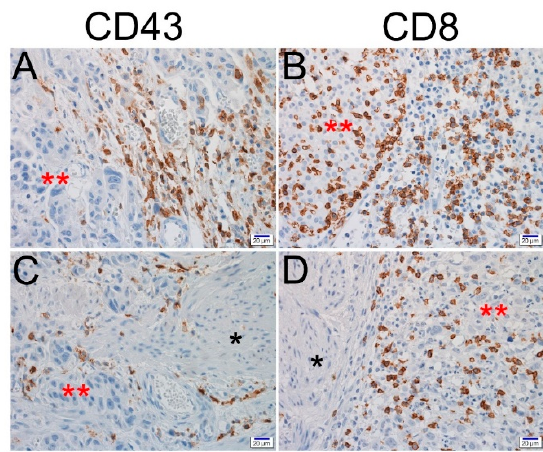
Figure 2. Representative images of CD43 and CD8 immunohistochemical staining in urothelial carcinoma of the bladder (UCB). Positive expression of CD43 and CD8 in intra-tumoral or contiguous peritumoral immune cells of lamina propria invasion ( A , B ) and muscularis propria ( C , D ) (scale bar = 20 µ m; *, muscularis propria; and **, tumor cells). J. Clin. Med. 2020 , 9 , x FOR PEER REVIEW